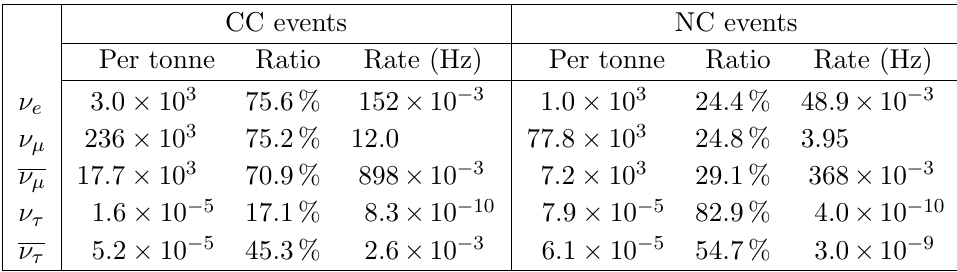
Table 4 . The expected rates for CC and NC interaction in the near detector are presented here, normalised to 10 20 POT. The values were computed starting from eq. (5.2), convolving the (cid:13)uxes of (cid:12)gure 3 with the CC and NC cross section predictions from genie [128]. Detector e(cid:14)ciencies are not applied. The (cid:12)rst columns show the total number of events per tonne of argon, the second ones the proportion of CC or NC events with respect to the totality, and the last columns the event frequencies assuming 1 (cid:2) 10 14